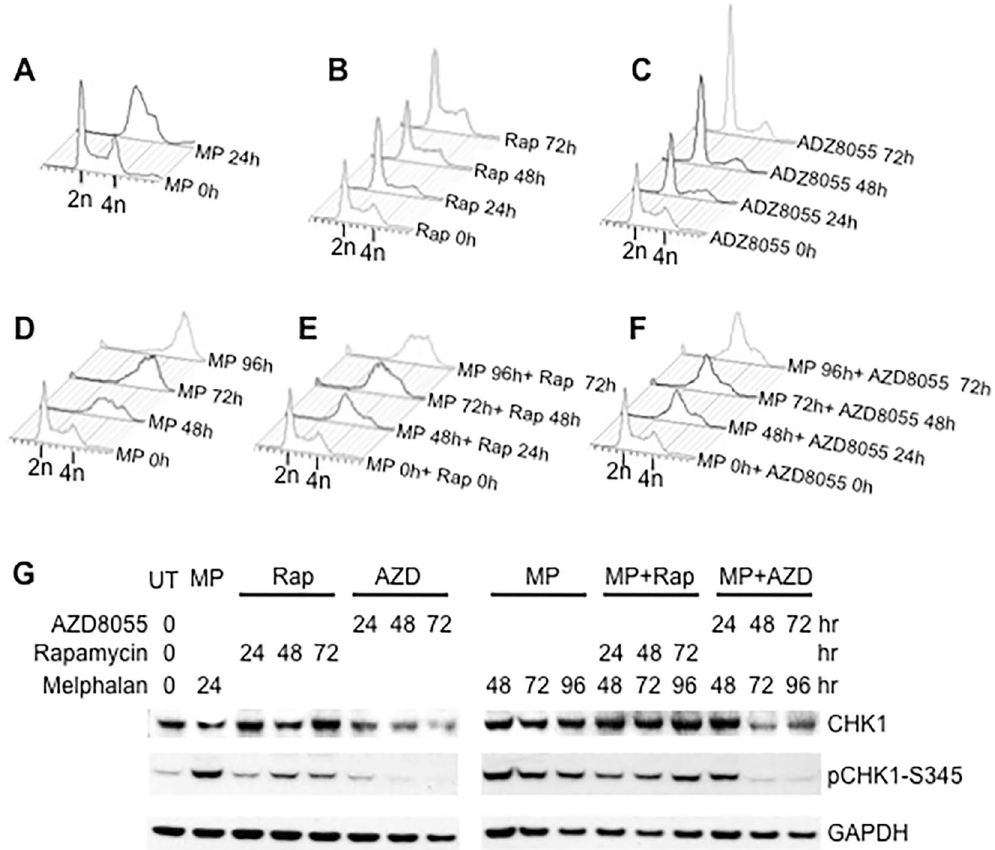
Figure 7. The mTOR Pathway Promotes the S Phase Progression in Response to Mephalan. ( A ) Rh30 cells were arrested in S phase by 2 μ g/mL melphalan for 24 hr. ( B ) Rapamycin (100 nM) was added to asynchronous cells for 24, 48 and 72 hr. ( C ) AZD8055 was added to asynchronous cells for 24, 48 and 72 hr. ( D ) Cells were exposed to melphalan for 96 hr. ( E ) cells were arrested by melphalan (24 hr) then exposed to rapamycin for an additional 24, 48 and 72 hr. ( F ) as in ( E ) but cells were exposed to AZD8055 (2 μ M). Cell cycle progression was monitored by flowcytometry to show DNA content. 2n, diploid DNA; 4n, tetraploid DNA. MP, melphalan. ( G ) Protein extracts of the same experiments of Fig. 7A–F were used for immunoblotting to detect pCHK1-S345 and CHK1. UT, untreated; MP, melphalan; Rap, rapamycin; AZD, AZD8055. GAPDH served as loading controls. Immunoblots were converted to gray with auto tone by Photoshop